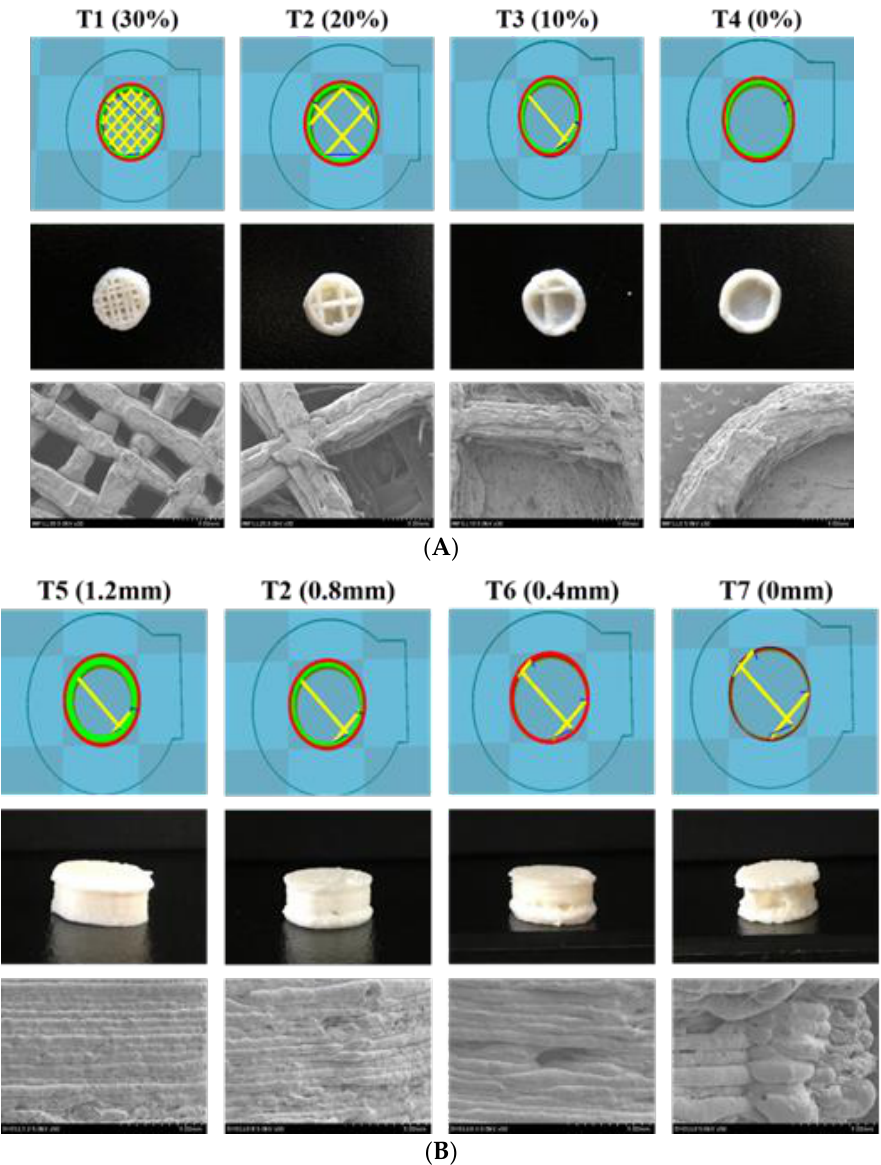
Figure 2. 3D tablet design templates, tablet photographs, and SEM images of 3D printed tablet surface with ( A ) constant shell thickness (0.8 mm), different infill percentages (T1 30%, T2 20%, T3 10%, and T4 0%) and ( B ) constant infill percentage (20%), different shell thickness (T5 1.2 mm, T2 0.8 mm, T6 0.4 mm, and T7 0 mm).